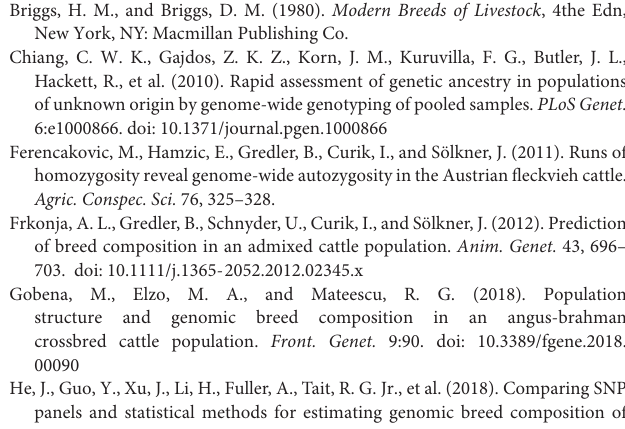
Supplementary Figure 1 | Map view of three SNP panels used in the present study: (A) 10K SNP panel, (B) 5K SNP panel, and (C) 1K SNP panel. Supplementary Figure 2 | Hierarchical clustering of eight reference breeds used in the present study as the reference. Supplementary Figure 3 | Histograms of SNP allele A frequencies in eight reference breeds and two composite breeds. Supplementary Table 1 | Path analysis for 7,969 Brangus animals using the genotype data, and evaluated by three SNP panels (1K, 5K, and 10K). The putative ancestral reference breeds consisted of eight reference beef breeds. The Brangus animals were genotyped on either GGP 30K/GGP 40K bovine SNP chip or GGP 50K bovine SNP chip,